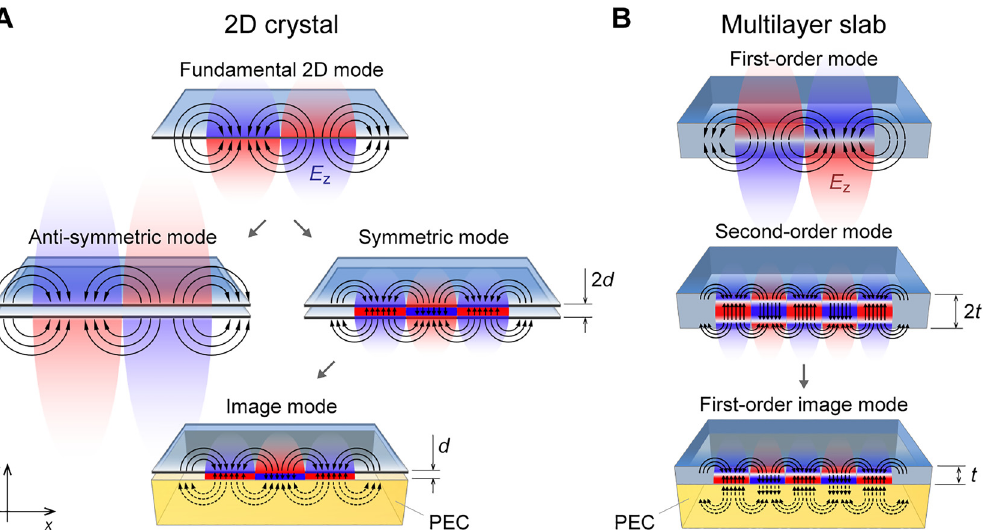
Figure 1: Two types of image polaritons in van der Waals crystals. Black curves schematically show the instantaneous electric field of the propagating polariton mode, and colors depict the evanescent z -component of the fi eld, which can be detected by near- fi eld microscopy. (A) Image mode in a 2D sheet, corresponding to the symmetricmode in a system of two closely placed monolayersof a van der Waalsmaterial separated by a dielectric spacer of thickness d . (B) Image mode in a multilayer slab, corresponding to the second-order waveguide mode in a van der Waals crystal that has twice the thickness t of its counterpart interfacing a perfect electric conductor